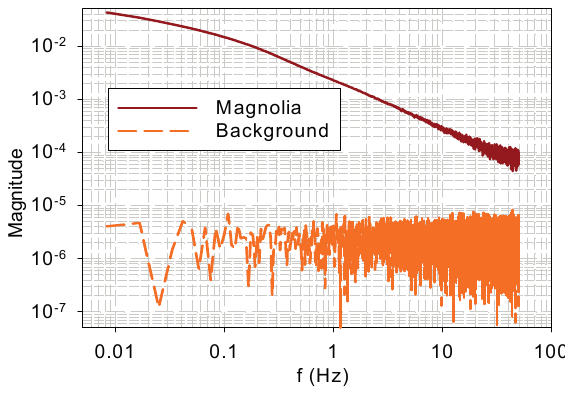
Figure 3. Comparison of DF and background